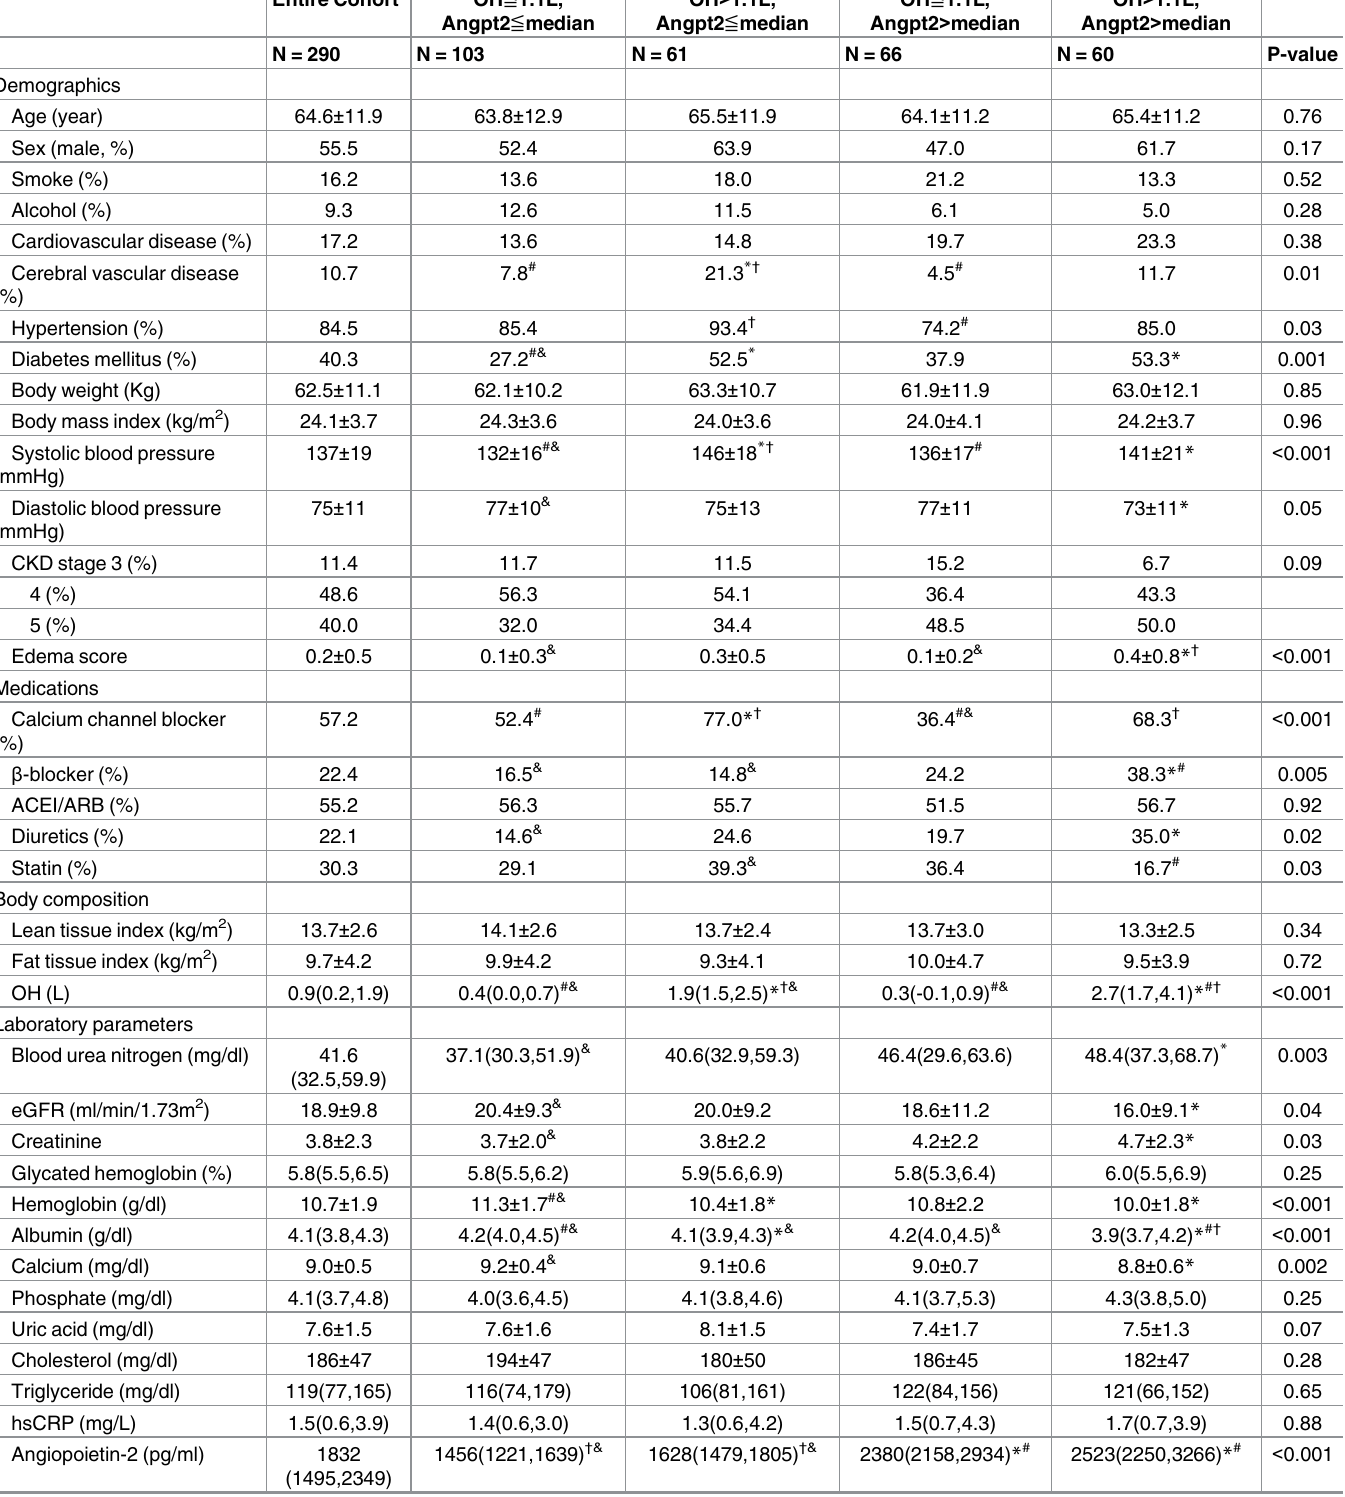
Table 1. The clinical characteristics of study subjects stratified by fluid status and circulating angiopoietin-2 (Angpt2)